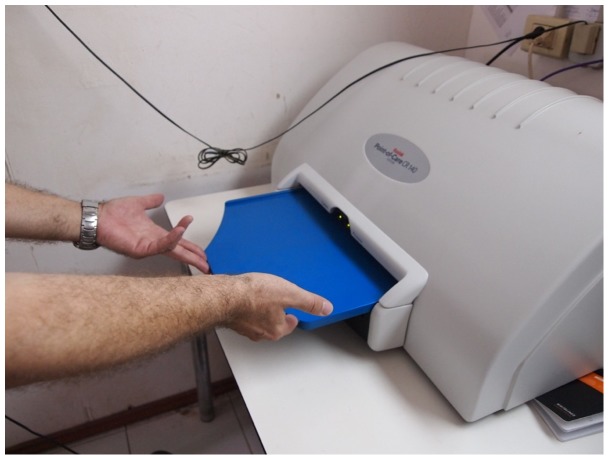
The system for acquisition of digital images (POC 130).